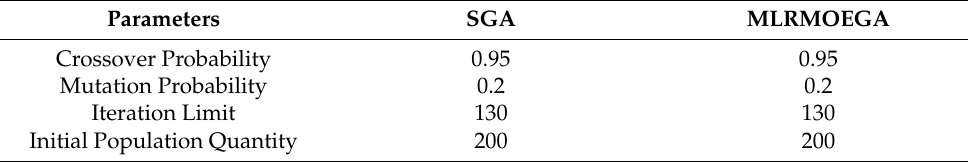
Figure 16. The grid map of the testing environment (20 × 20 grid cells). The design parameters of SGA and MLRMOEGA are shown in Table 6. Table 6. The parameters of SGA and